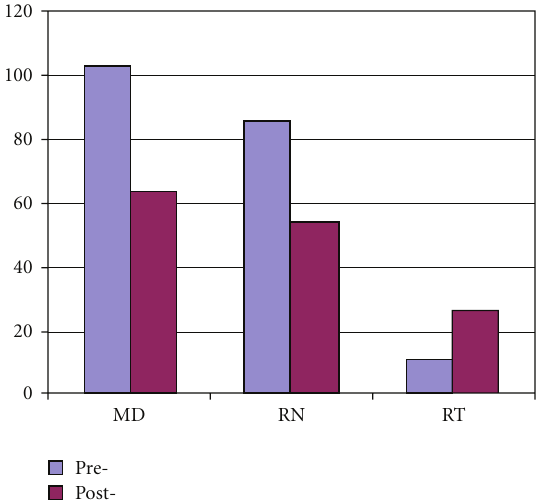
Figure 2: Caregiver type among survey participants.